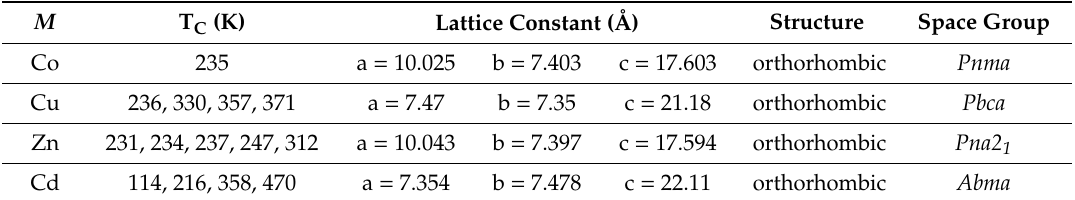
Table 1. The phase transition temperatures, T C , lattice constants, structures, and space groups